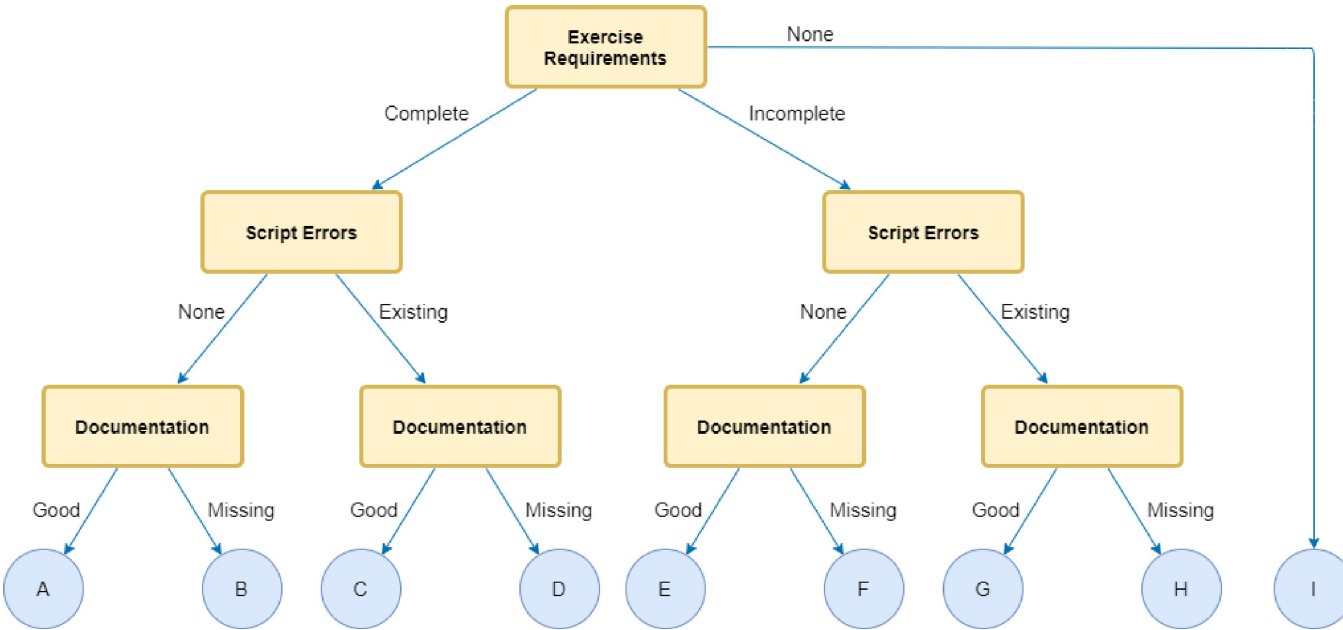
Fig 4. Decision tree demonstrating how rubrics were used to classify notebooks in the final group